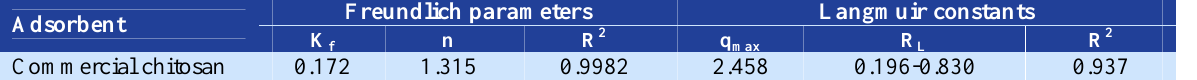
Table 1. Langmuir and Freundlich isotherm constants and correlation coefficients Freundlich parameters Adsorbent Commercial chitosan